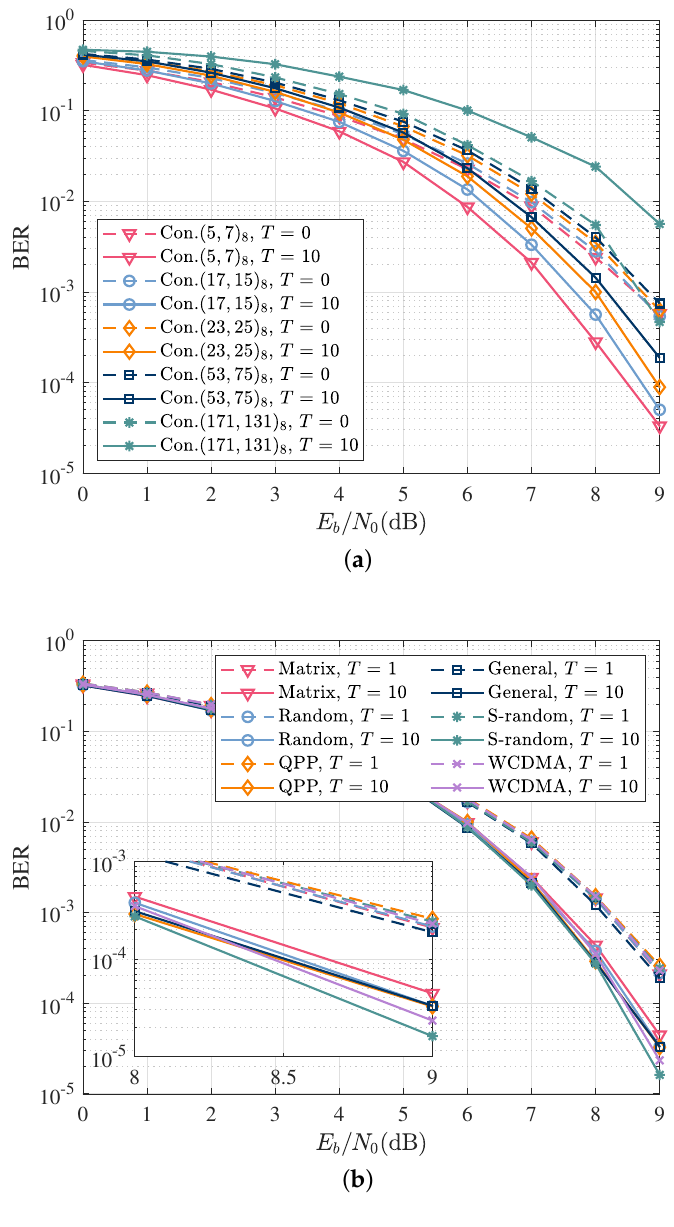
Figure 5. The performance of different convolutional codes and interleavers with perfect channel knowledge. The dashed and solid curves refer to the performance of the optimal coherent detector after the first iteration ( T = 1) and the tenth iteration ( T = 10), respectively. ( a ) BER as a function of E b / N 0 for different convolutional codes; ( b ) BER as a function of E b / N 0 for different